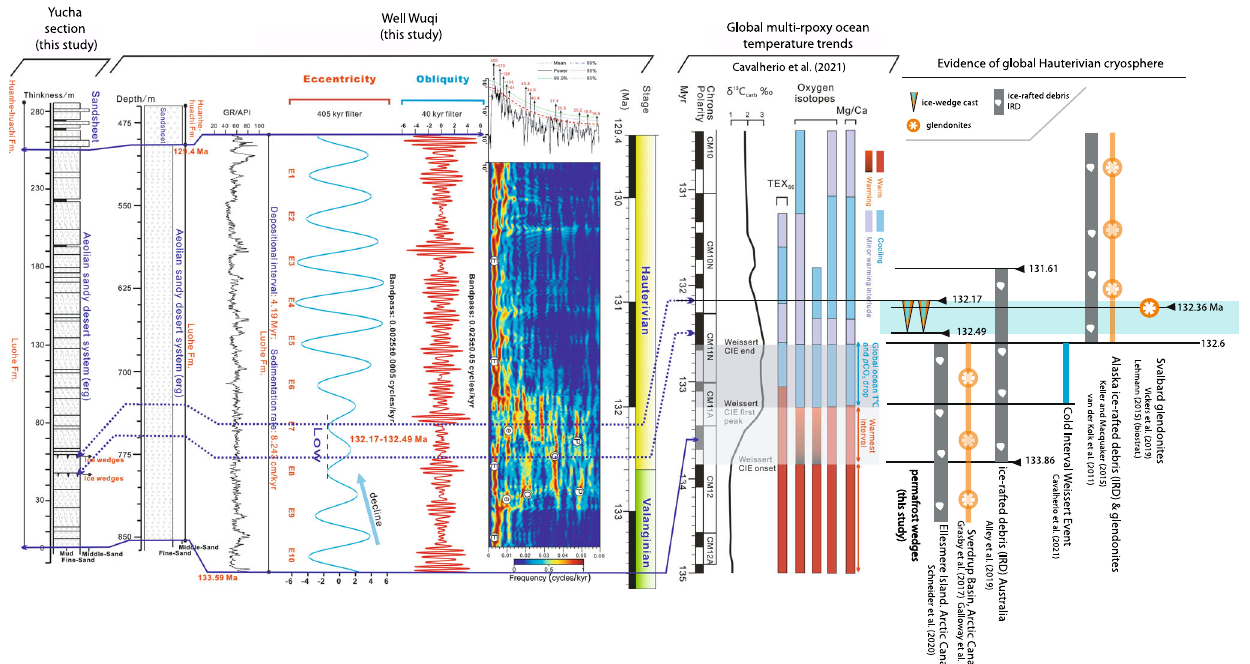
Fig. 7 | Chronostratigraphic interval containing permafrost sandstone wedges basedontheastrochronologyofWellWuqiintheOrdosBasin,andcorrelation with global multi-proxy oceantemperature trends and withother evidence of and active Cretaceous cryosphere. The δ 13 Ccarb curve, TEX 86 , oxygen isotopes, andMg/Caratiopalaeo-thermometry fromref.68andreferencestherein.Modi fi ed